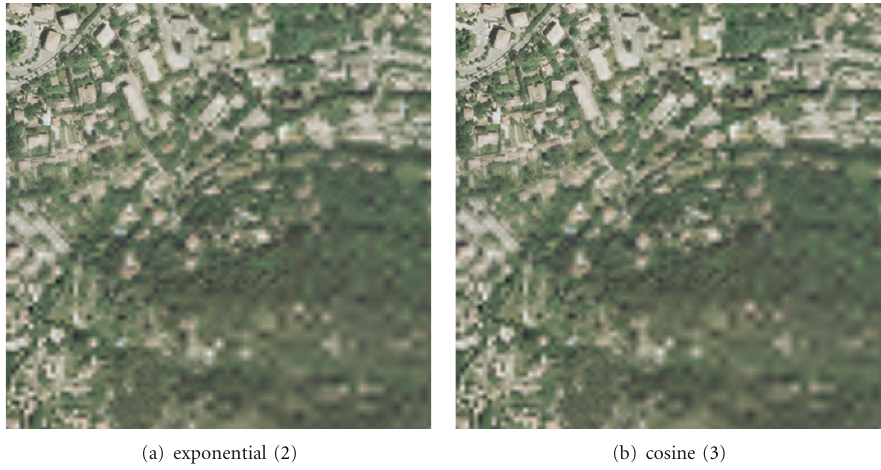
Figure 13: Method II as applied special smoothing functions: l h = 0, l m = 2, l l = 3.